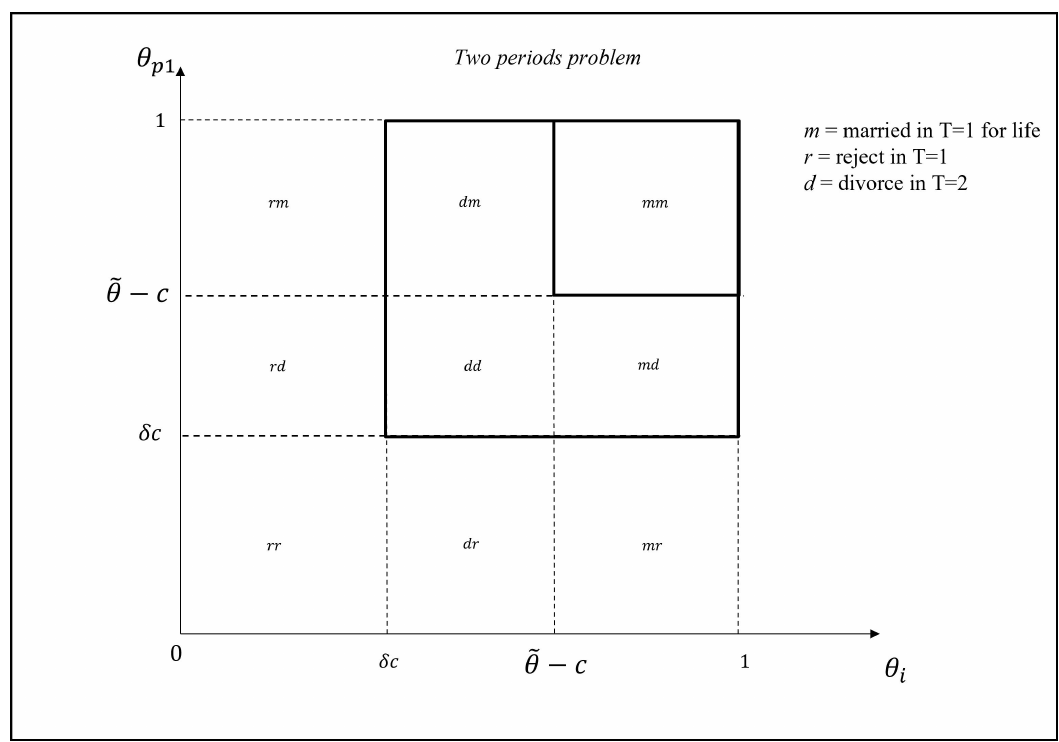
Figure A3. Divorce equilibrium in a 2-periods